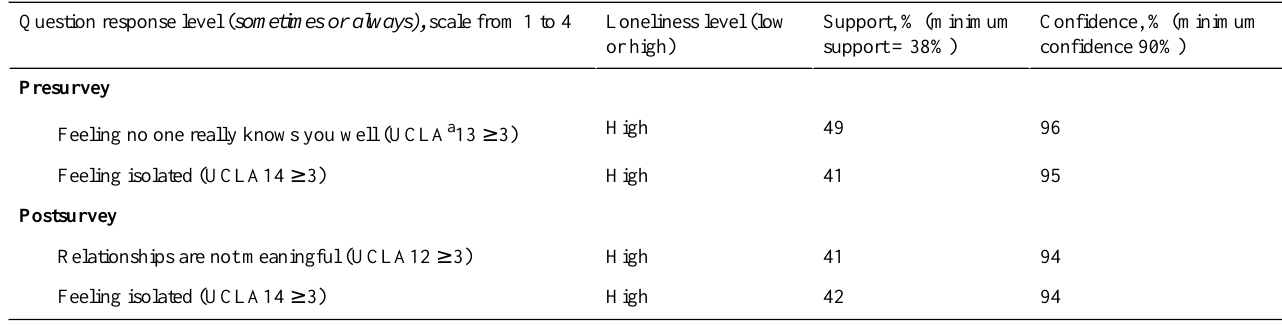
Table 4. Association rules extracted from pre- and postsurvey